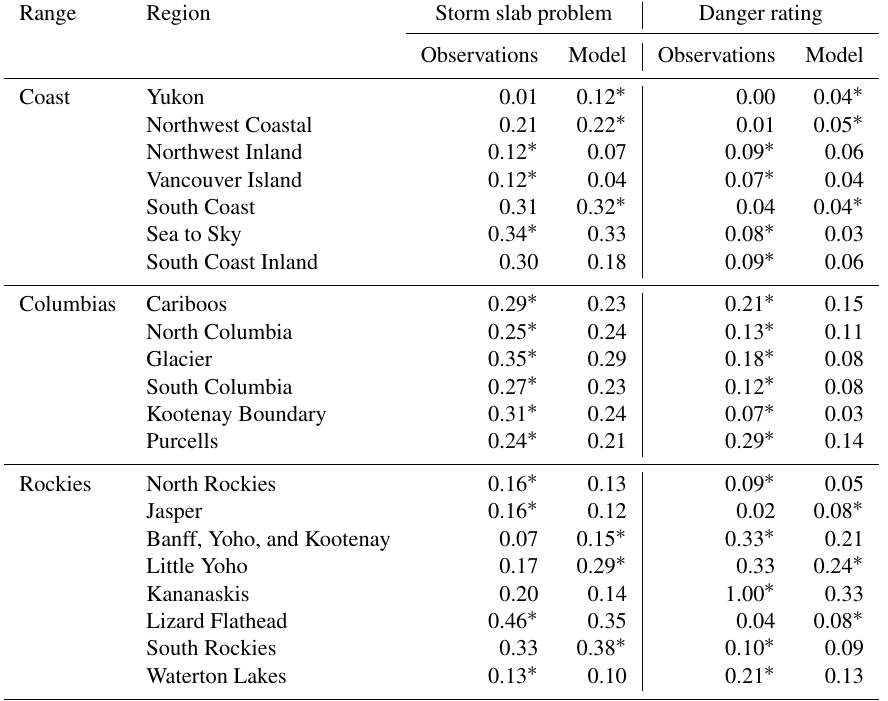
Table 1. Comparison of regression models predicting the presence of storm slab avalanche problems and danger ratings with modelled data versus upscaled observation data. McFadden’s pseudo- R 2 values are listed for each model to compare their goodness of fit. The model with the better fit for each region is identified with an